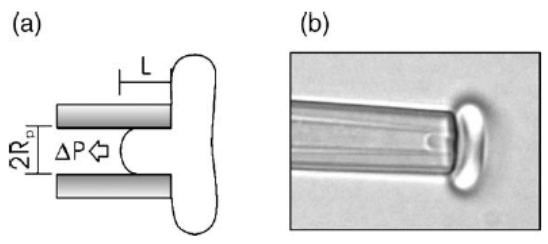
Fig. 3 (a) Schematic of the micropipette aspiration method, and (b) optical image showing aspiration of a RBC. (Reprinted from Lim et al . (12) with permission from Elsevier) Zhou et al. (11) and Lim et al. (25) used the micropipette aspiration to examine the progression of the disease state of a P. falciparum infected red cell from the early ring form stage to the late schizont stage (see Figure 4). Using a constant suction pressure, the amount of cell aspirated into the pipette was observed at each different stage of infection. One interesting finding is that while the healthy and early stage infected red cell was found to behave like a “liquid drop” and can be easily aspirated, the late schizont stage infected RBC tended to exhibit a viscoelastic solid-like behavior and can hardly be aspirated into the pipette. This arises due to the gross molecular and cellular structural changes of the infected RBC as well as the multiplication of the parasites within the cell. Due to the solid-like behavior of the late stage infected cell, Lim et al . (25) modeled the deformability of the whole cell using a homogeneous incompressible standard neo-Hookean solid model. The apparent bulk shear modulus of the schizont stage infected red cell was calculated to be about 50 Pa.